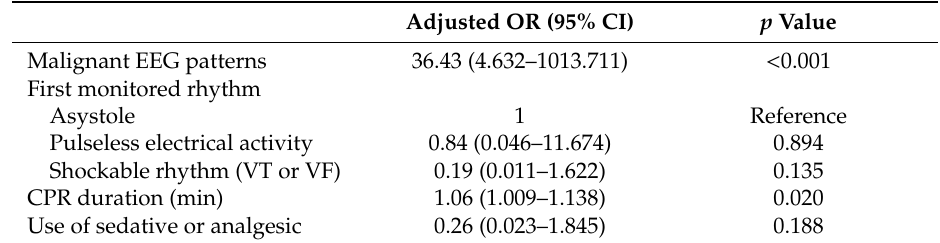
Table 4. Multivariable logistic regression of clinically relevant variables associated with poor neurological outcomes.